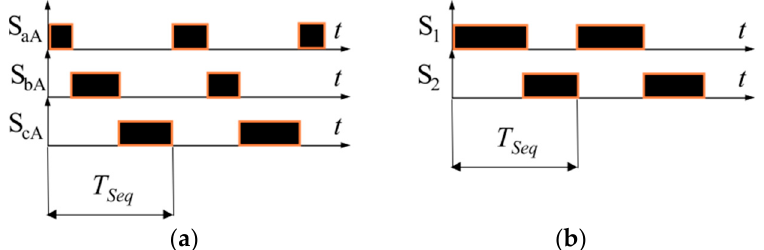
Figure 11. Distribution of control pulses in a single period of the control sequence T Seq : ( a ) in the phase leg of a matrix converter, ( b ) in the phase leg of a classical inverter.